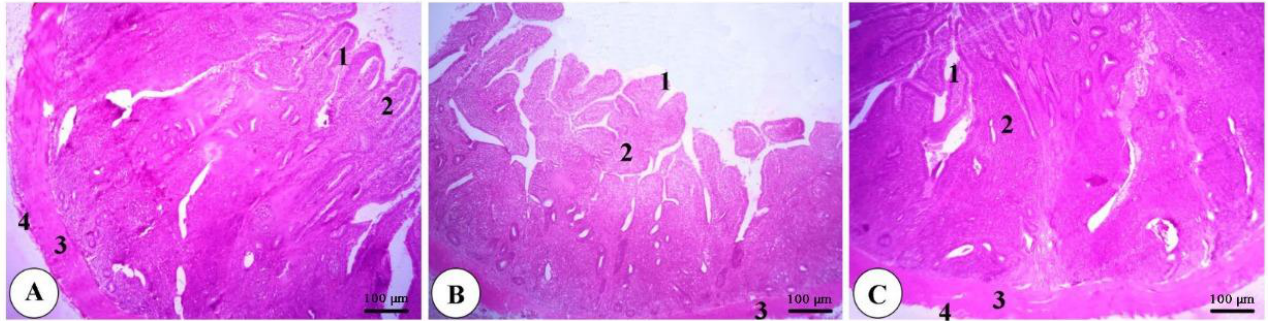
Figure 2. Representative photomicrograph of the ileum of a broiler of the dry feed ( A ), wet feed ( B ) and fermented wet feed ( C ) groups showing the simple columnar epithelium of the tunica mucosa (1), connective tissue core of intestinal villi (2), tunica muscularis (3) and tunica serosa (4). H&E, bar = 100 µm. ( n = 8).